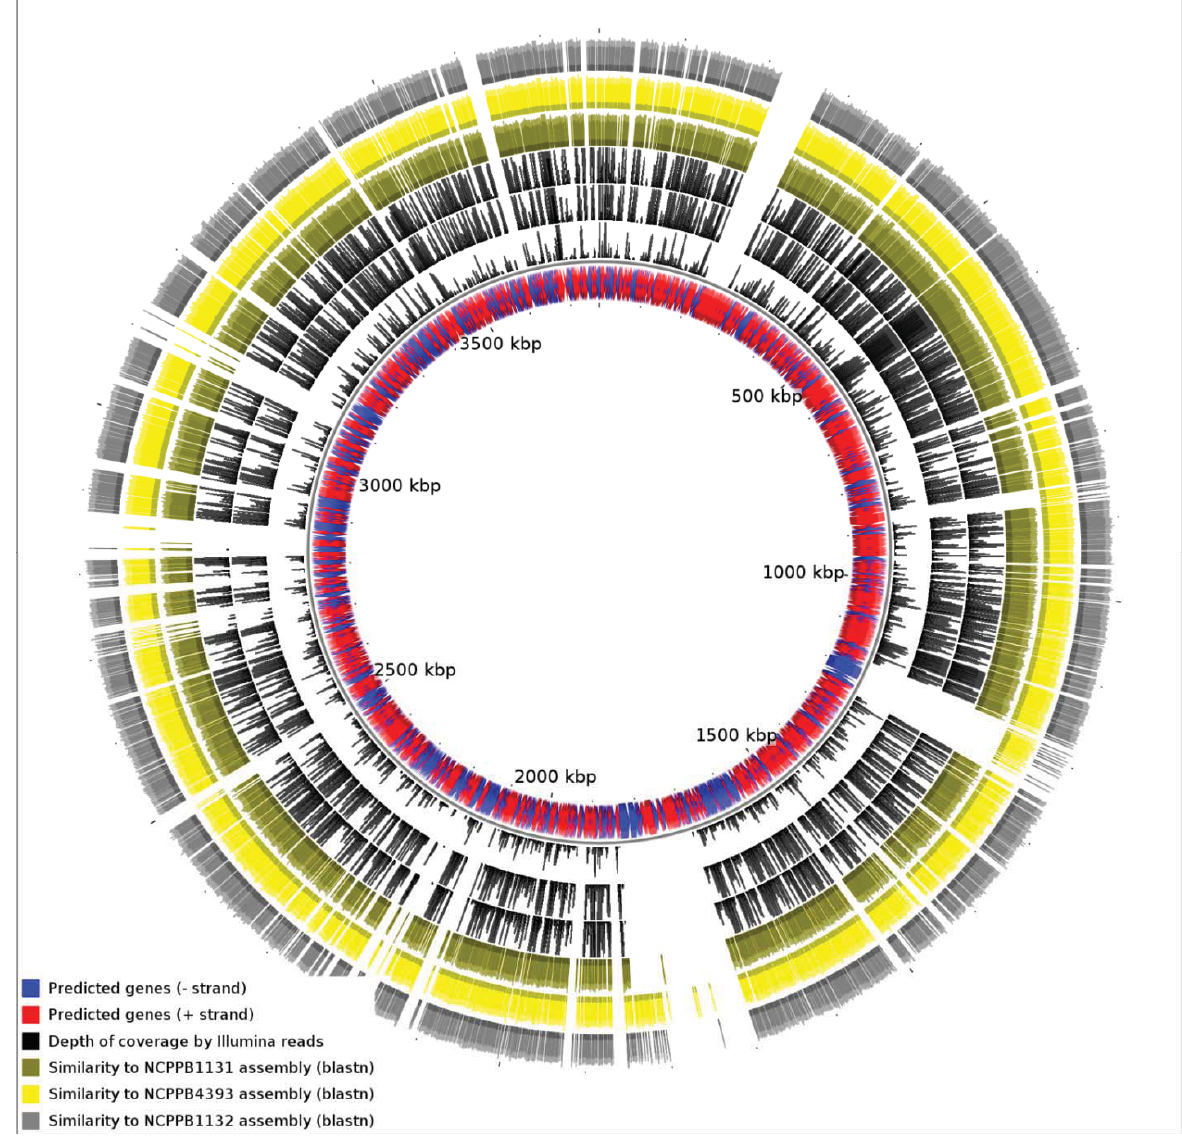
Figure 3. Alignment of the three Xanthomonas Group 1 new genome sequences against the chromosome of X. albilineans. The blue and red inner track represents annotated genes. The next three black tracks represent depth of coverage by Illumina sequence reads for NCPPB1131, NCPPB4393 and NCPPB1131 respectively. The four colored outer rings indicate sequence similarity to the genome assemblies of NCPPB1131 (olive), NCPPB4393 (yellow) and NCPPB1131 (grey)